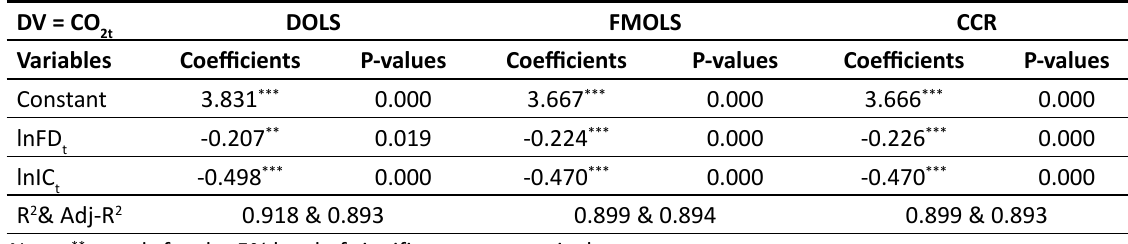
Table 8: DOLS, FMOLS, and CCR